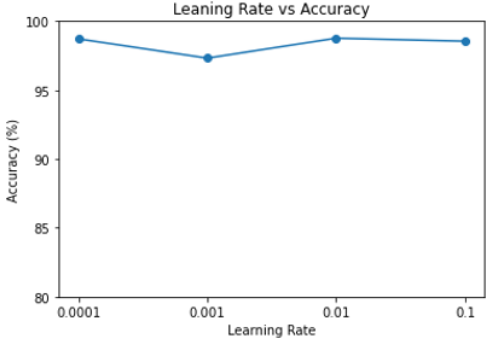
Figure 12. Impact of Learning Rate on